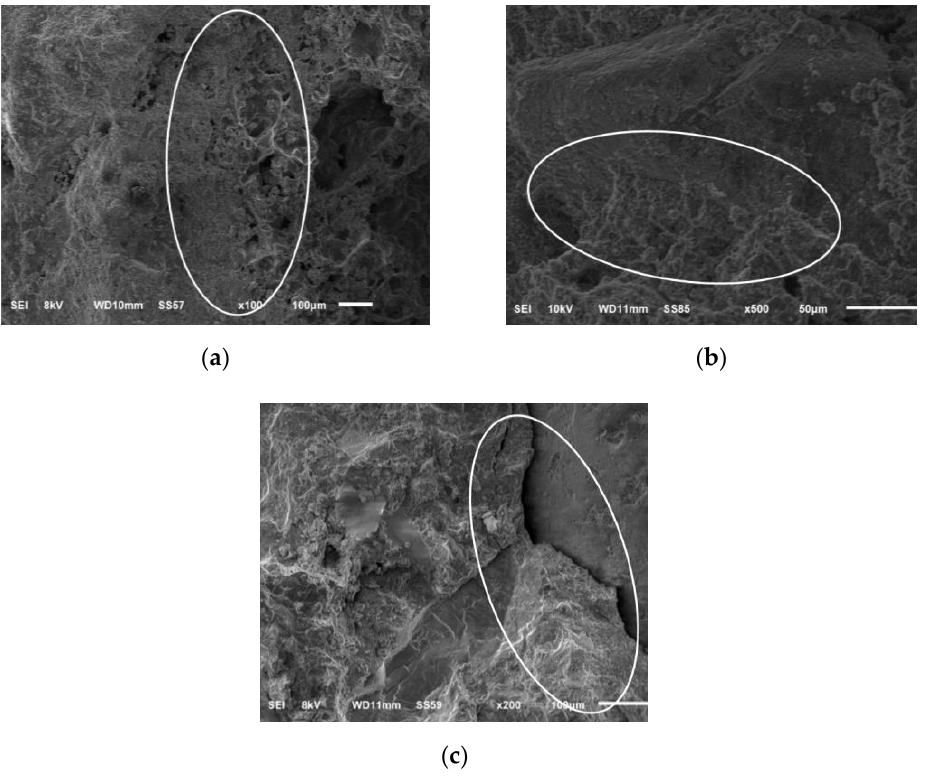
Figure 5. Contact layer “cement stone—aggregate” through a microscope: ( a ) composition C3-II; ( b ) composition C4-II, ( c ) composition С5-II.